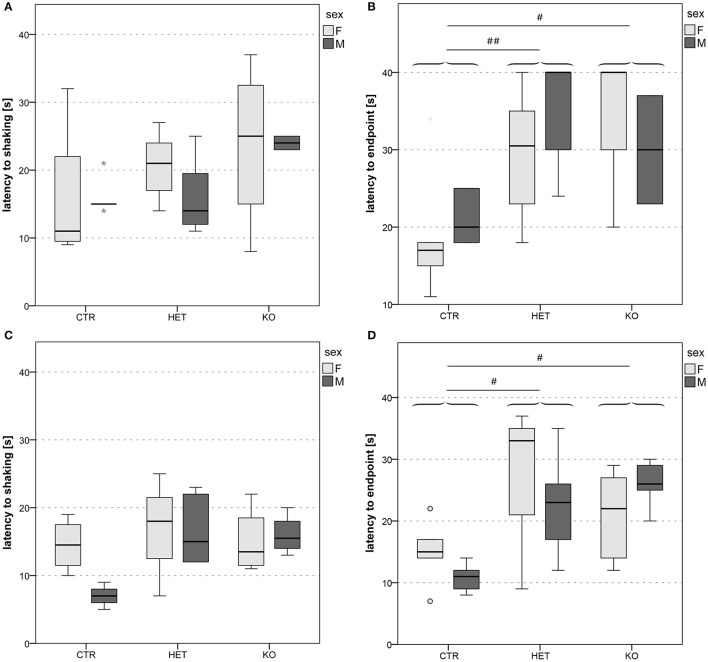
Reactivity to thermal pain: lower pain sensitivity in KO and HET than in CTR mice. Latency to shaking (A,C) and latency to endpoint (B,D) in hot plate 1 (A,B) and hot plate 2 (C,D). In both cohorts of mice, latency to endpoint was longer in both KO and HET than in CTR mice (B,D), whereas latency to hindpaw shaking did not differ between genotypes (A,C). Boxes filled in light and dark gray represent data of female and male mice, respectively. (n = 9 CTR, 12 HET, 6 KO for hot plate 1, n = 7 CTR, 9 HET, 8 KO for hot plate 2). (#p < 0.05, ##p < 0.01).